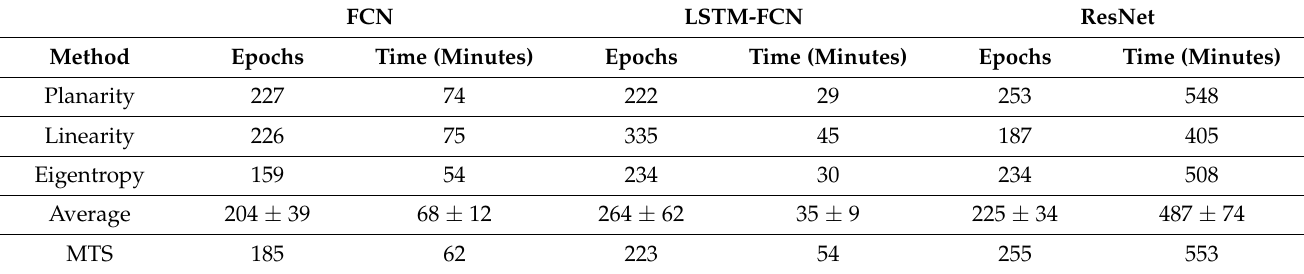
Table 3. The number of epochs and training time of univariable (UTS) and multivariable time series (MTS) model for FCN, LSMT-FCN, and ResNet; the number of epochs is the sum of the epochs of the fivefold cross-validation method; average is the mean of the number of epochs and training time of the three UTS methods (UTS: Planarity; Linearity; Eigentropy, MTS: